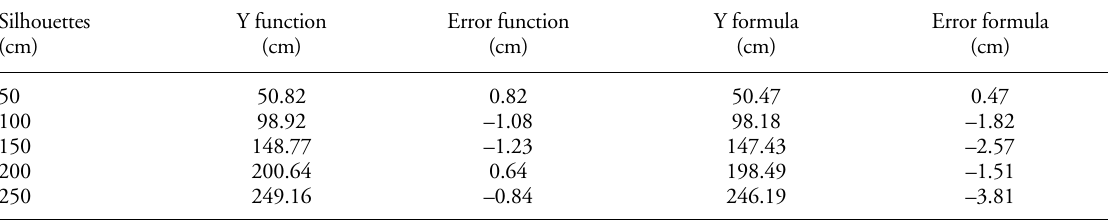
Table 3. Mean error measurements for shoulder height estimates of elephant silhouettes according to models (statistical and geometrical).